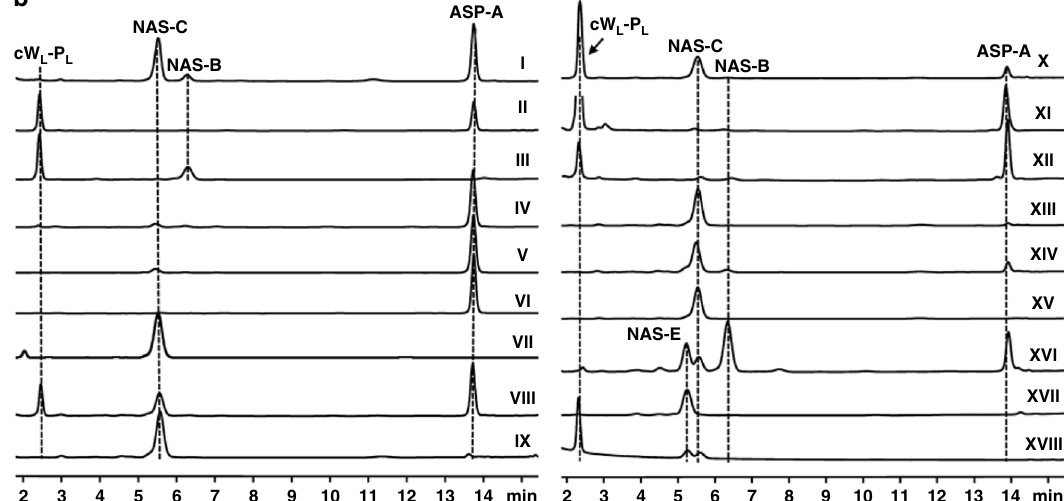
Fig. 2 Deciphering and engineering the regio-speci fi city and stereo-speci fi city of HTDKP forming P450s. a The sequence alignments of NascB, Nasc F5053 , and Nas S1868 . The identical N-terminal and C-terminal parts of NascB/NasF 5053 and Nas F5053 /Nas S1868 are shaded in orange and light green, respectively. Residues less important are not shown and indicated by dashed lines. The four critical residues are bolded and highlighted by colors. b In vitro characterization of P450s and their mutants using cW L -P L as substrate. (I) Nasc F5053 ; (II) Nas S1868 ; (III) NasbB; (IV) Nas F5053 -Q65I; (V) Nas F5053